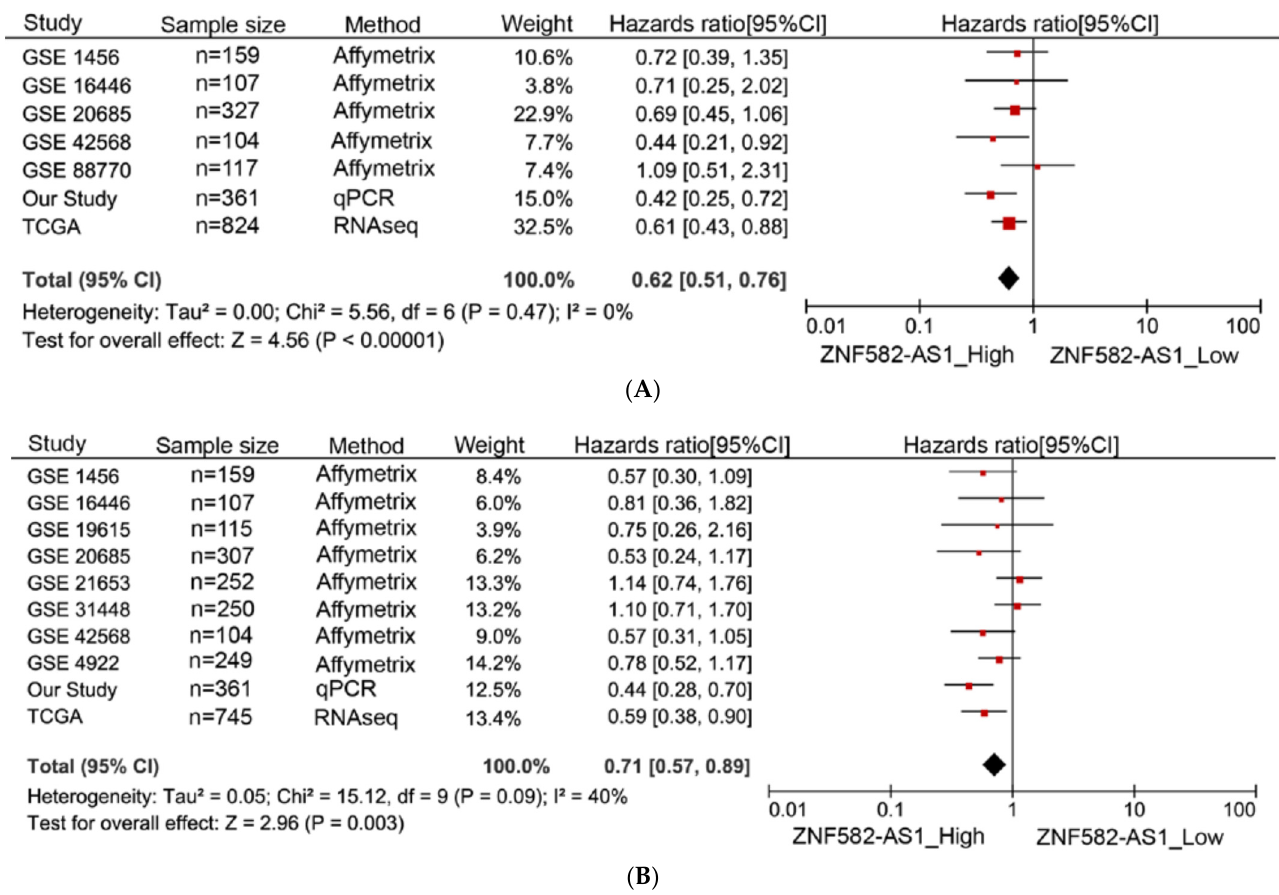
Figure 3. Meta-analysis of associations between ZNF582-AS1 expression and breast cancer survival. ( A ) ZNF582-AS1 expression (high vs. low) in association with overall survival (OS). ( B ) ZNF582-AS1 expression (high vs. low) in association with disease-free survival (DFS).